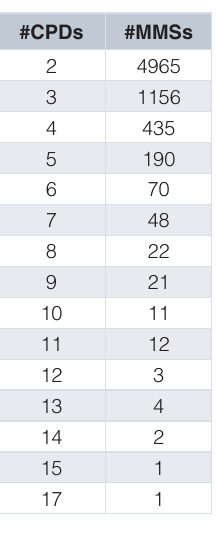
Compound series and parameters